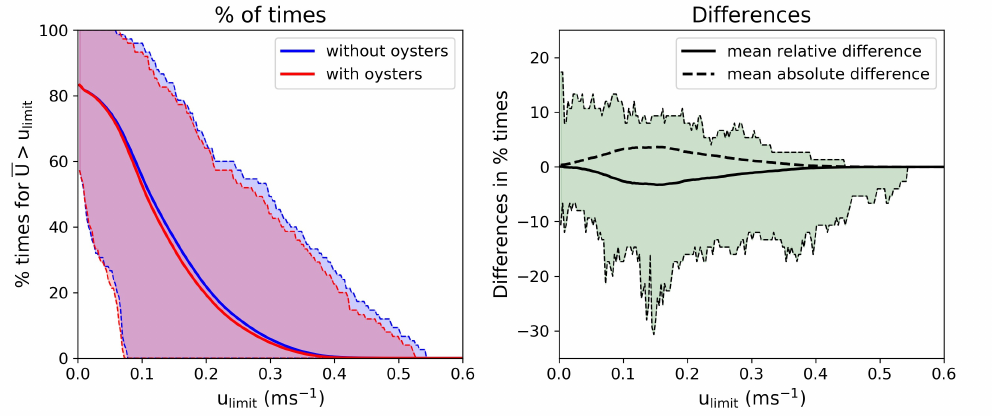
Figure 15. ( left ) (filled line) Evolution of the fraction of the time ¯ u > u limit during a mean spring tidal cycle, averaged over areas covered by oyster tables in simulations E 1 (without oysters) and E 3 (with oysters). The upper and lower lines show the maximum and minimum time percentages reached over oyster farming areas for a given value of u limit , respectively. ( right ) Mean relative and absolute differences (E 3 -E 2 ) between time percentages averaged over areas covered by oyster tables. Thus, the black line on this sub-figure shows the difference between filled lines on the left sub-figure. The upper and lower lines show the maximum and minimum differences in time percentages over oyster farming areas for a given value of u limit . Negative values show, therefore, a decrease of times percentages with oysters while positive values accounts for an